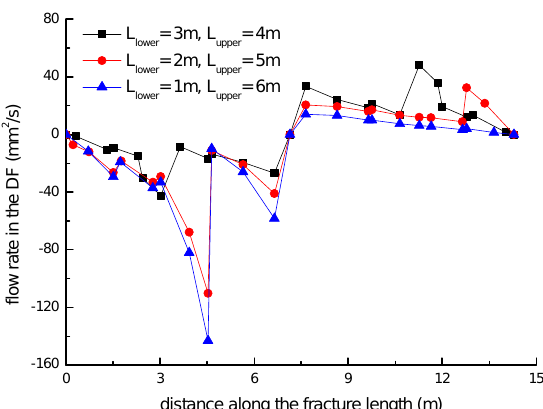
Figure 9. The flow rate curves in the DF along the fracture length at different lengths of the lower and upper parts of the NF. The distance in the x -axis is along the direction from the lower parts to the upper parts of the